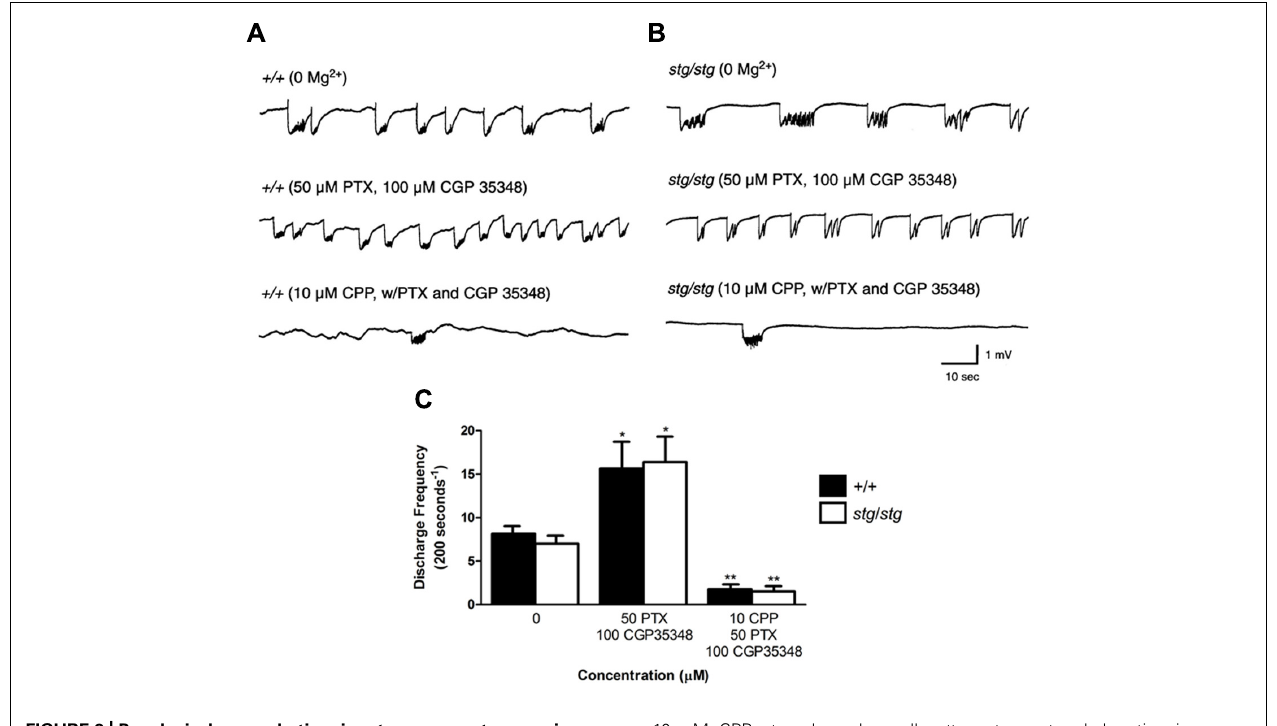
10 μ M CPP strongly and equally attenuates network bursting in both genotypes (lower traces). (C) Exacerbation of epileptiform discharges by CPP is not evident in WT or stargazer slices with complete GABAergic blockade ( n = 4 per group, * p < 0.05, ** p <